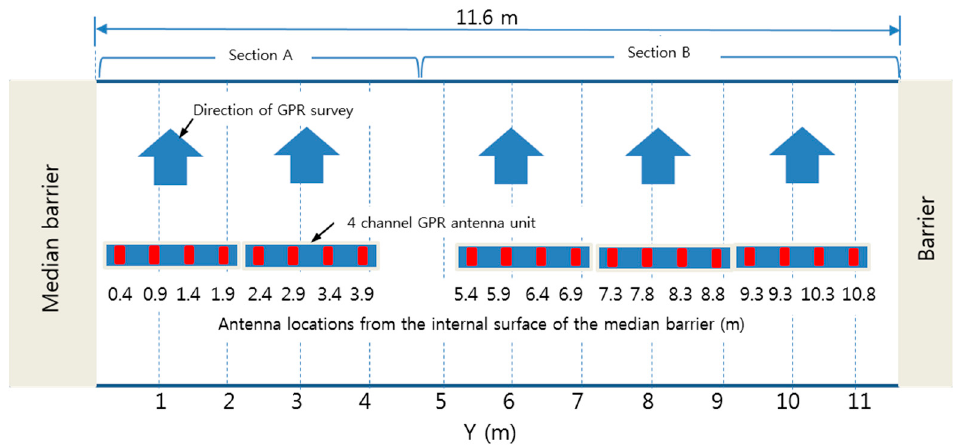
Figure 10. Illustration of GPR surveys on the target pilot ‘J’ bridge using a 1 GHz air-coupled GPR system (see Figure 2).